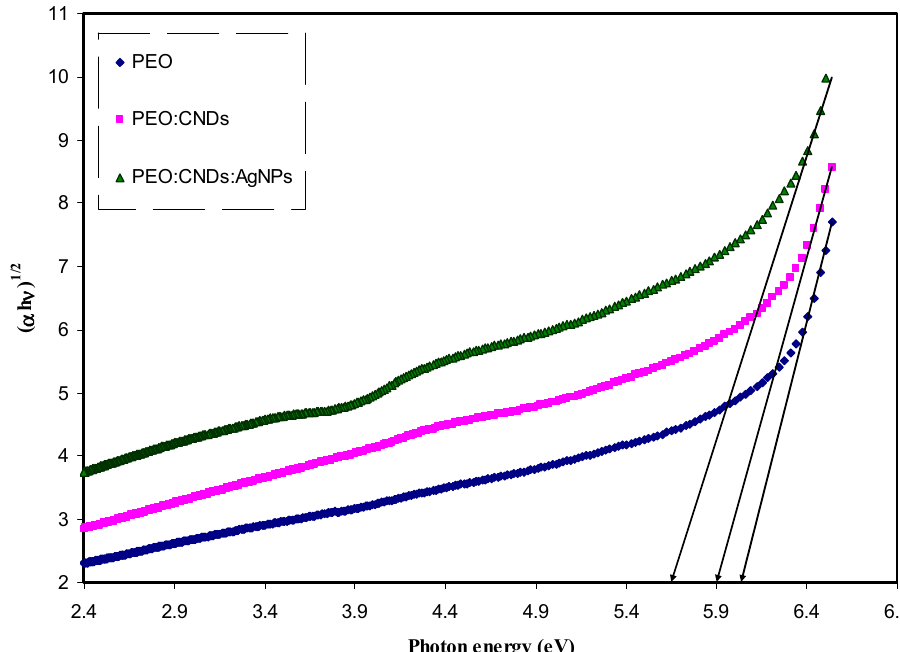
Figure 11. Plot of ( α h υ ) 1/3 vs. photon energy for pure PEO (PEPN0), PEO:CNDs (PEPN1), and PEO:CNDs:Ag (PEPN2) composite samples.